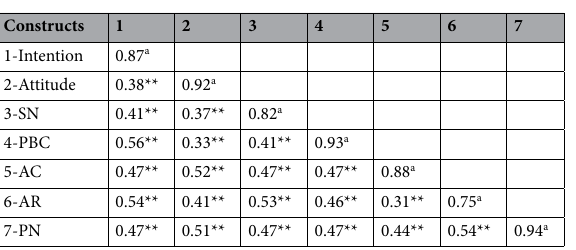
Table 5. Correlations with Square Roots of the AVE. **Correlation is significant at the < 0.01 level. a The square roots of AVE